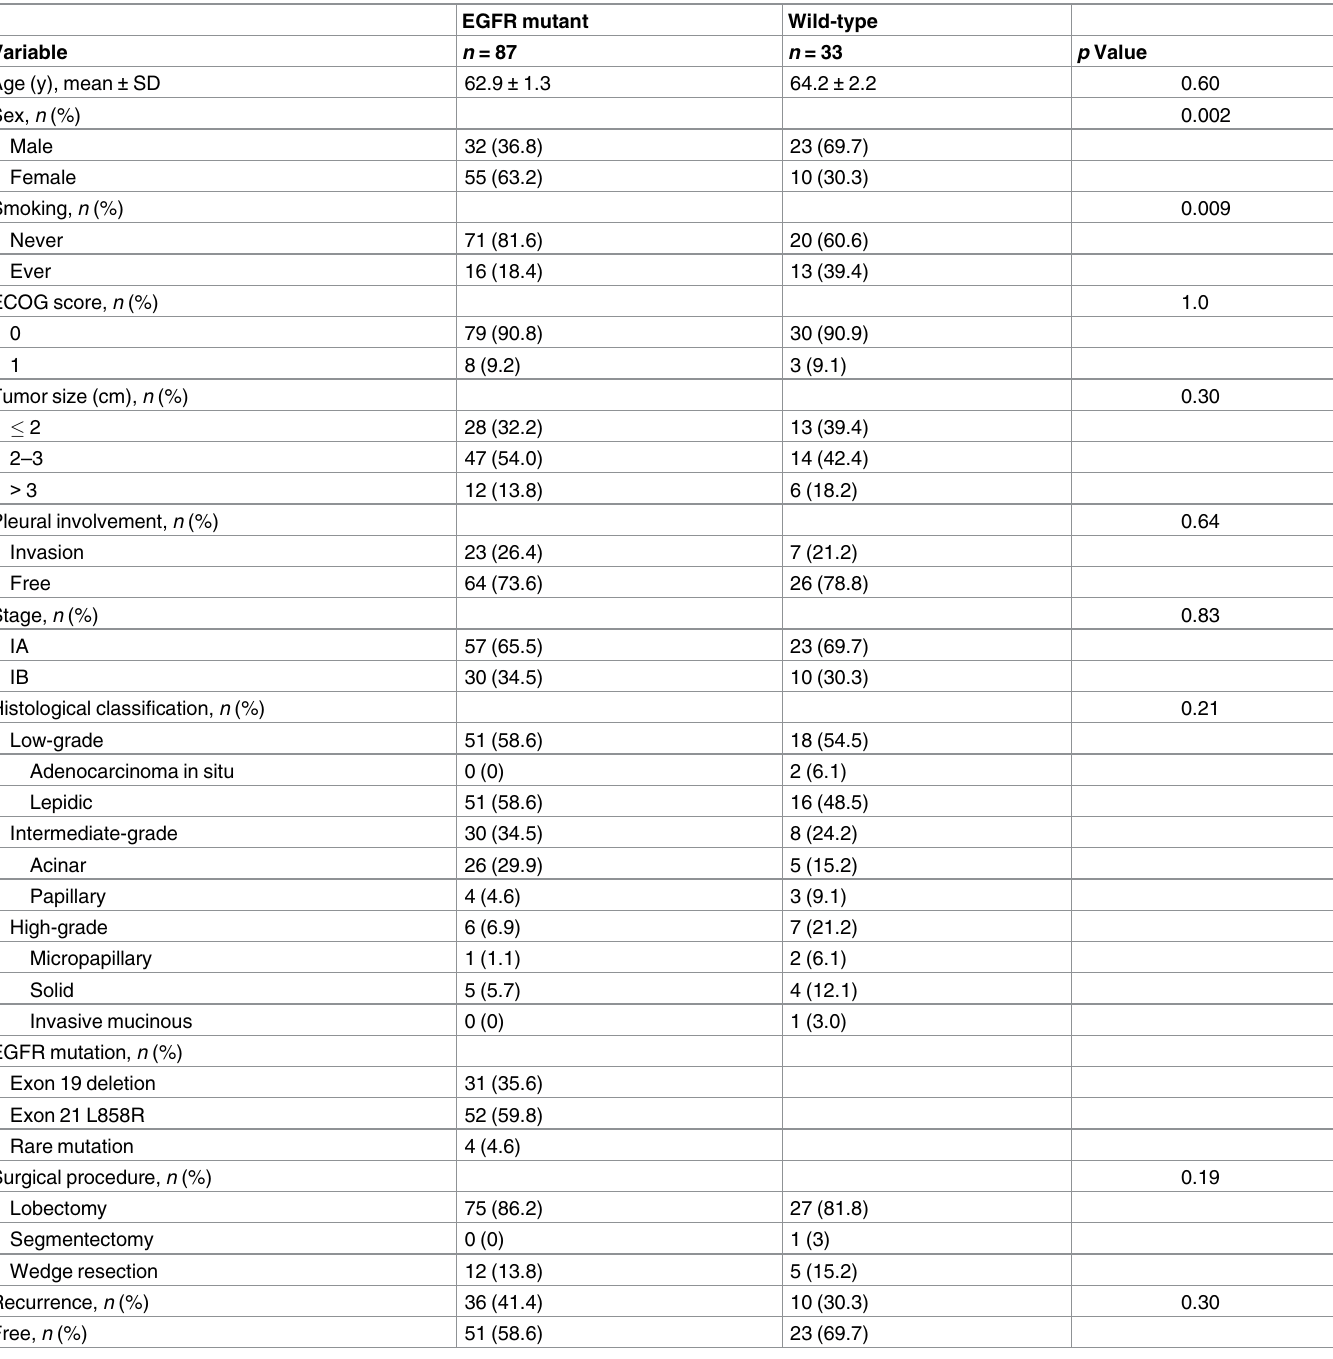
Table 1. Demographics of patients and tumor